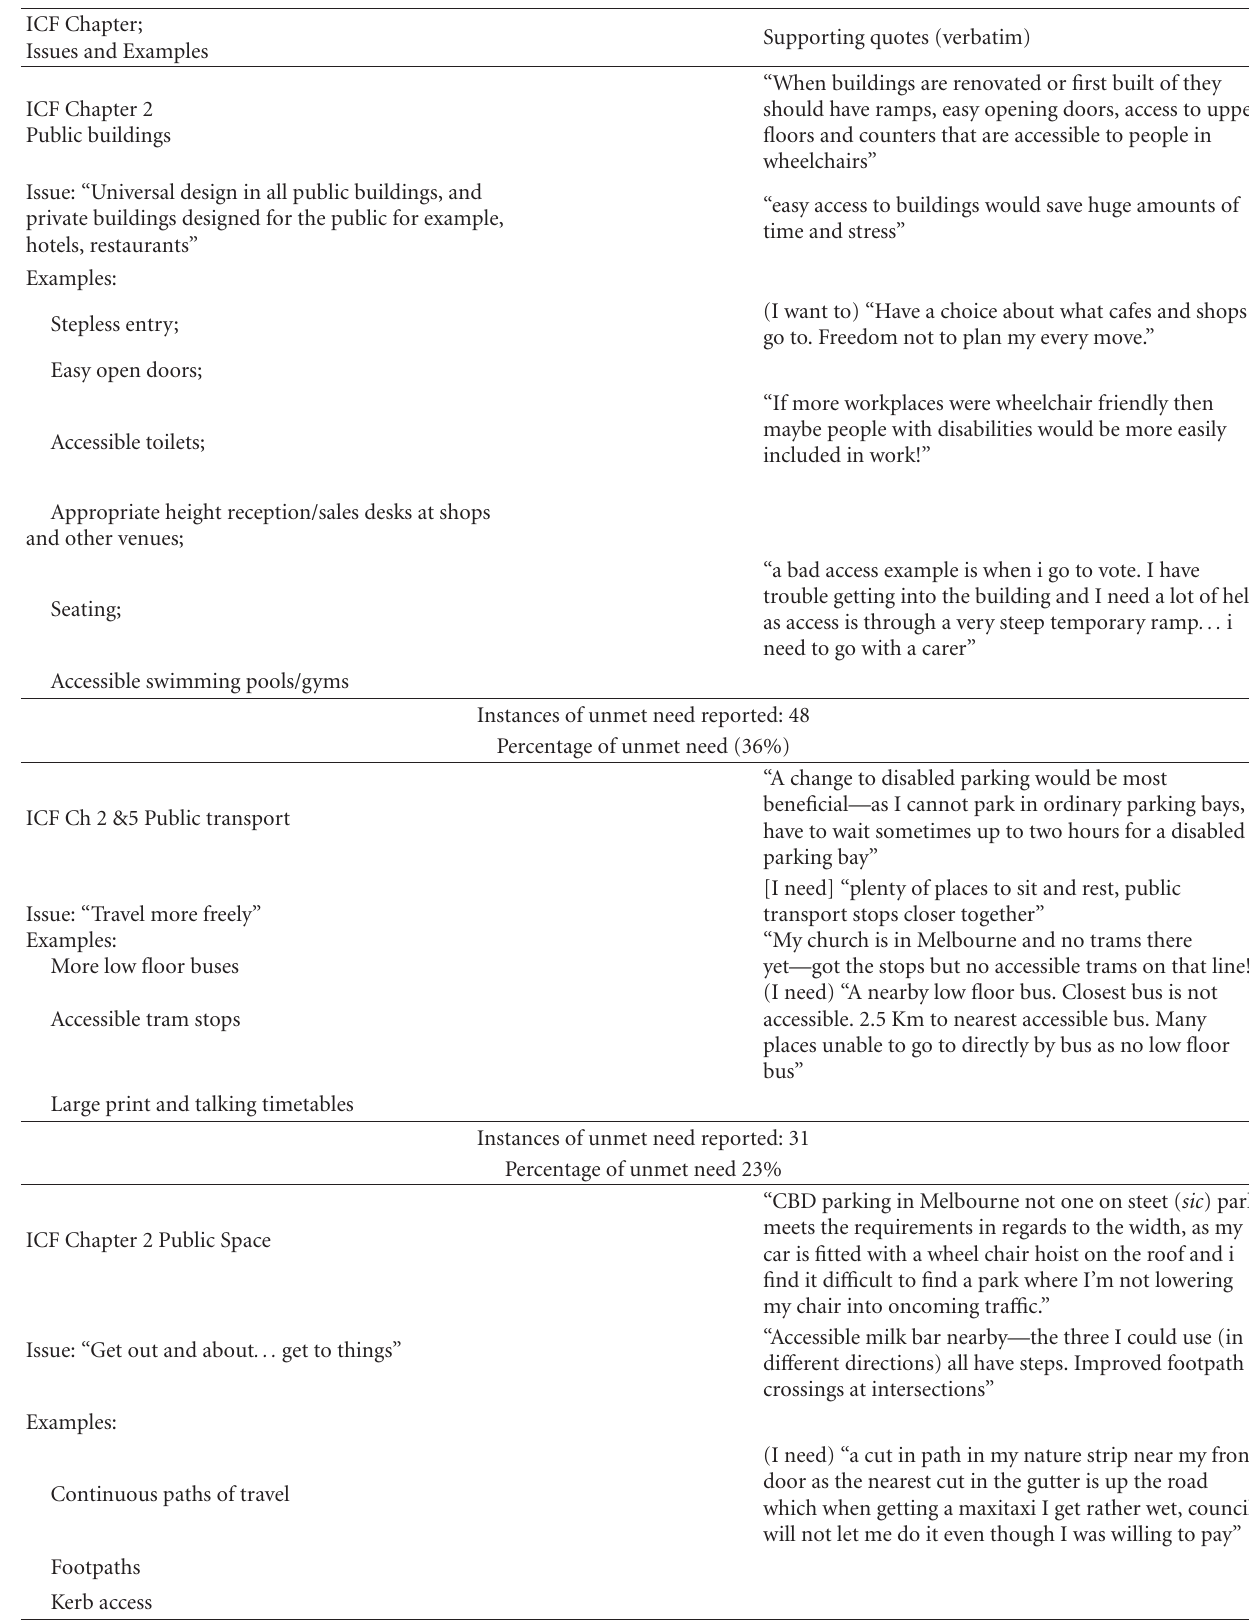
Table 3: Unmet need for accessible community